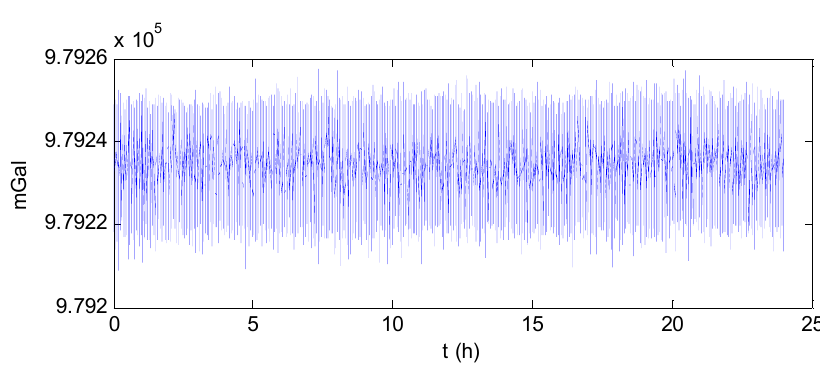
Figure 2. The raw gravimeter data on 27 May.